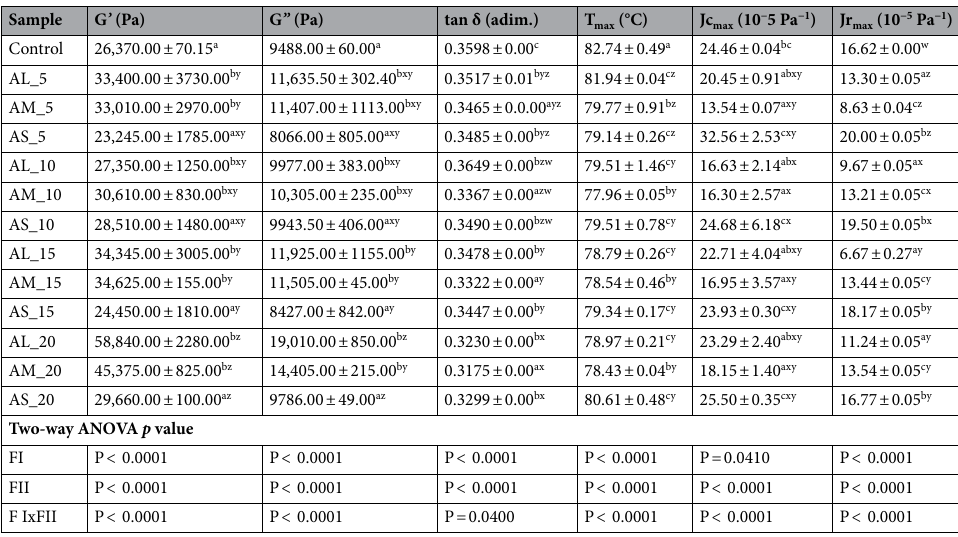
Table 1. Elastic and viscous moduli, loss tangent, maximum gelatinization temperature, and creep-recovery compliance of bread samples with different amaranth flour particle sizes, large (L), medium (M) and small (S) and wheat flour replacement levels (5, 10, 15 and 20). FI: amaranth flour particle size; FII: amaranth flour addition level; mean followed by the same alphabets in each column are not significantly different (P > 0.05); the first (a-c) and second (x-w) letter in each column indicates particle size and replacement level, respectively. G ′ : elastic modulus; G ″ : viscous modulus; tan δ: loss tangent; T max : maximum gelatinization temperature; Jc max , Jr max : maximum creep-recovery compliance.